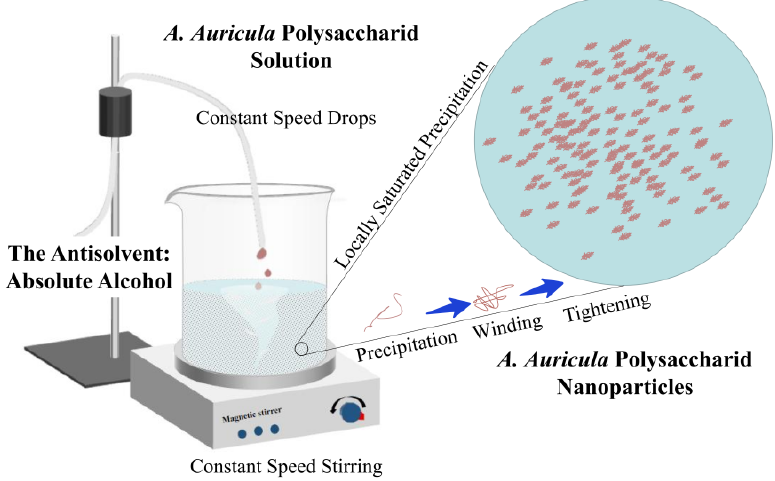
Figure 9. Formation of AAP-NPs via antisolvent precipitation.